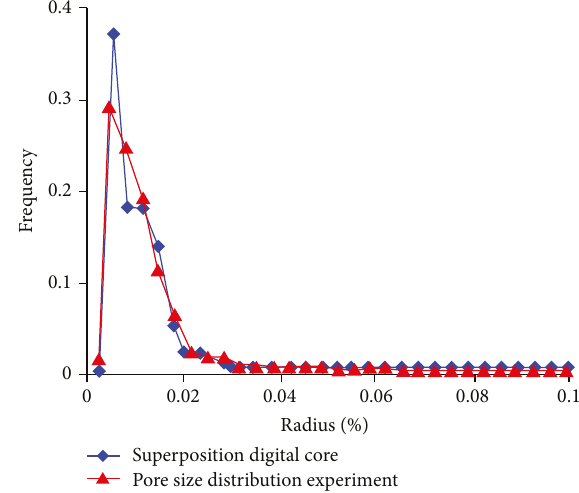
Figure 17: Comparing the pore size distribution of the 3D digital core obtained in Figure 13 with the experimental pore size distribution, it can be seen that the pore size distribution of the 3D digital core after nesting is in good agreement with the experimental data. Figure reprinted from